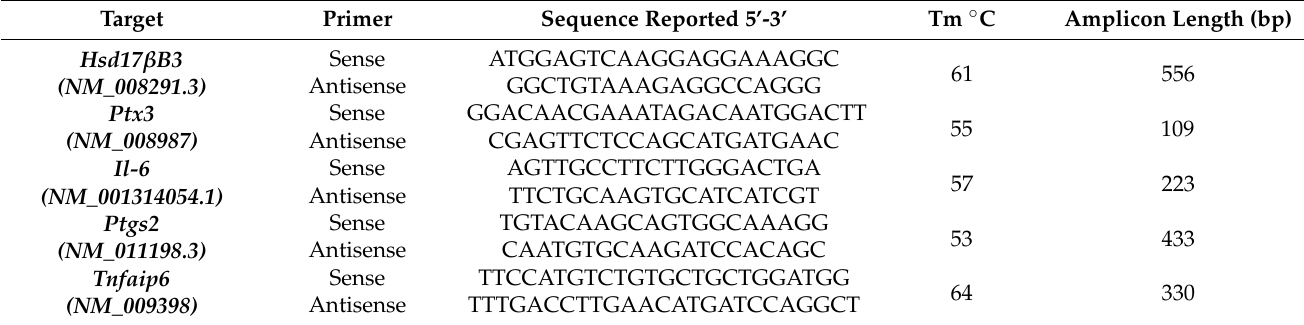
Table 1. Primer sequence for reverse transcription PCR in ovulated COCs related genes.